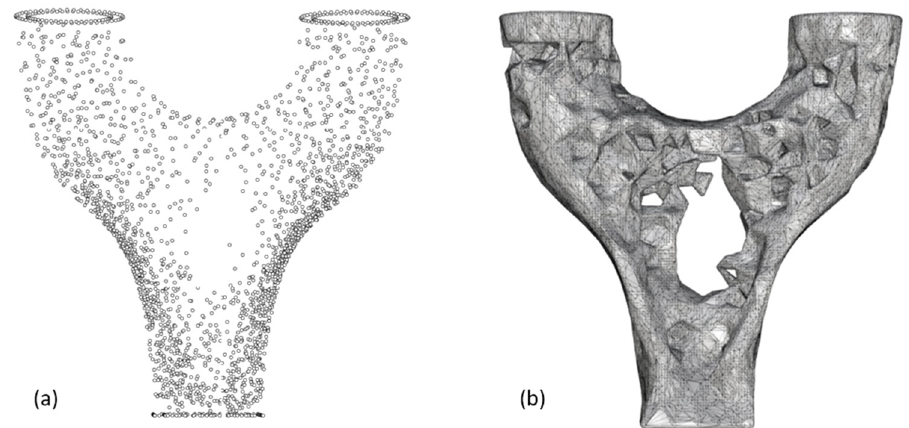
Figure 16. ( a ) Graphical representation of the points of the volumetric mesh as agents of the self- organizing system. ( b ) Representation of the geometry after an intermediate step for the transforma- tion from triangle mesh to quad mesh.